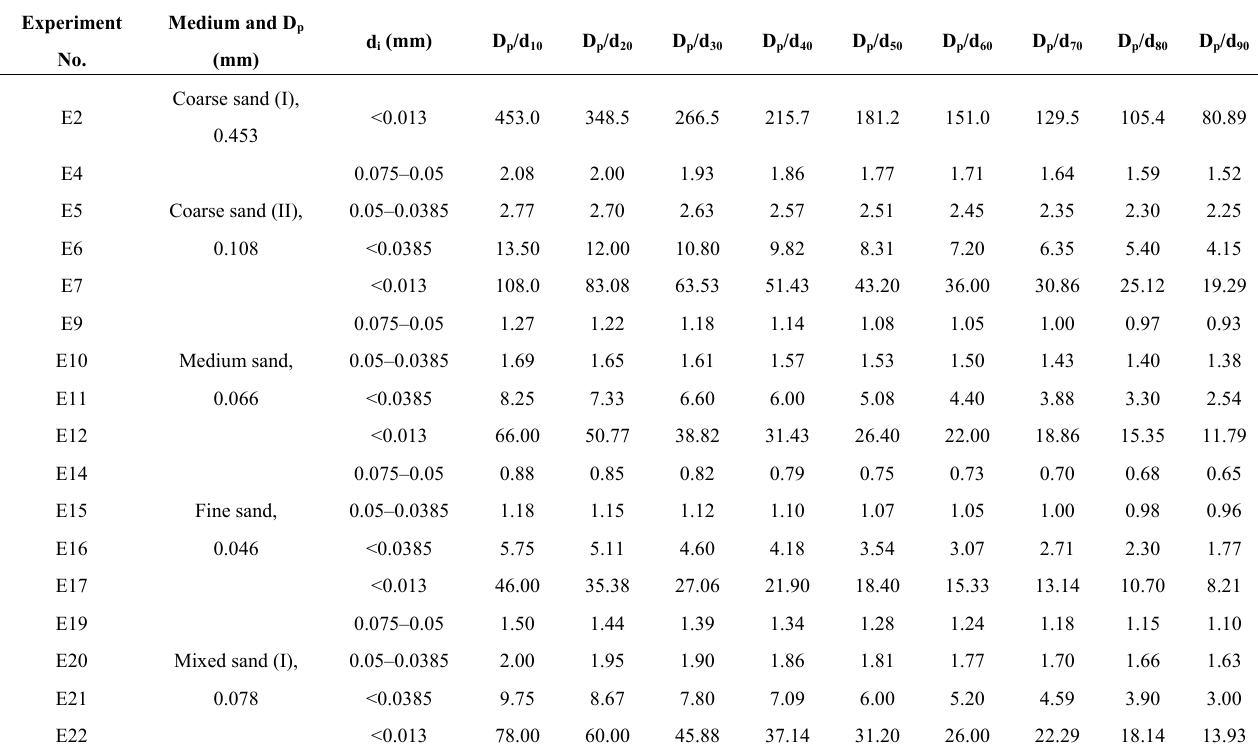
Table 2. Ratios of infiltration medium effective pore diameter (D solids grain diameter (d